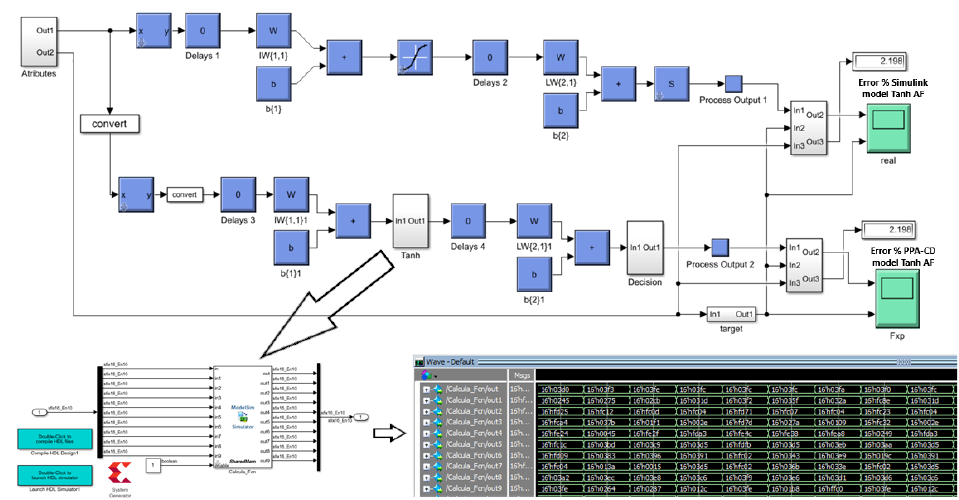
Figure 7. Breast cancer detection ANN performance